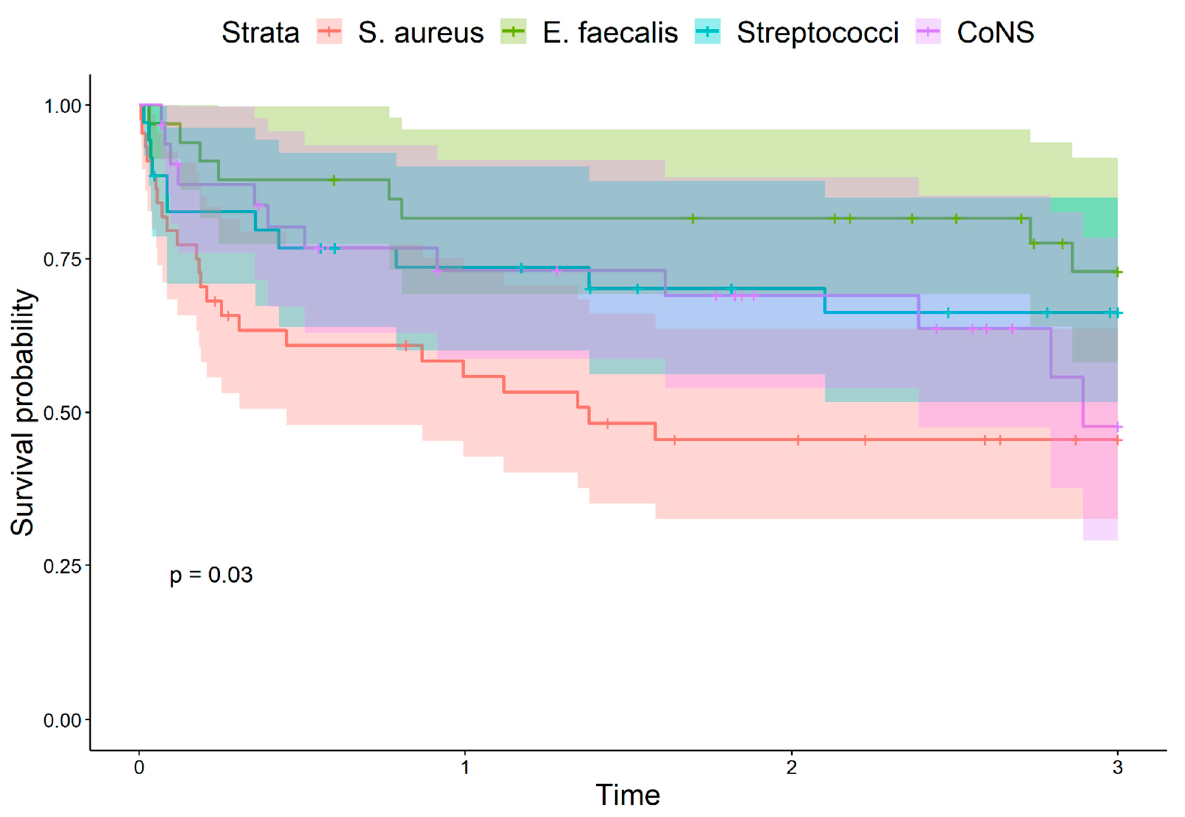
Figure 2. Kaplan–Meier 3-year survival curves when comparing IE groups presented with different causative microorganisms. p -value represents the overall differences.